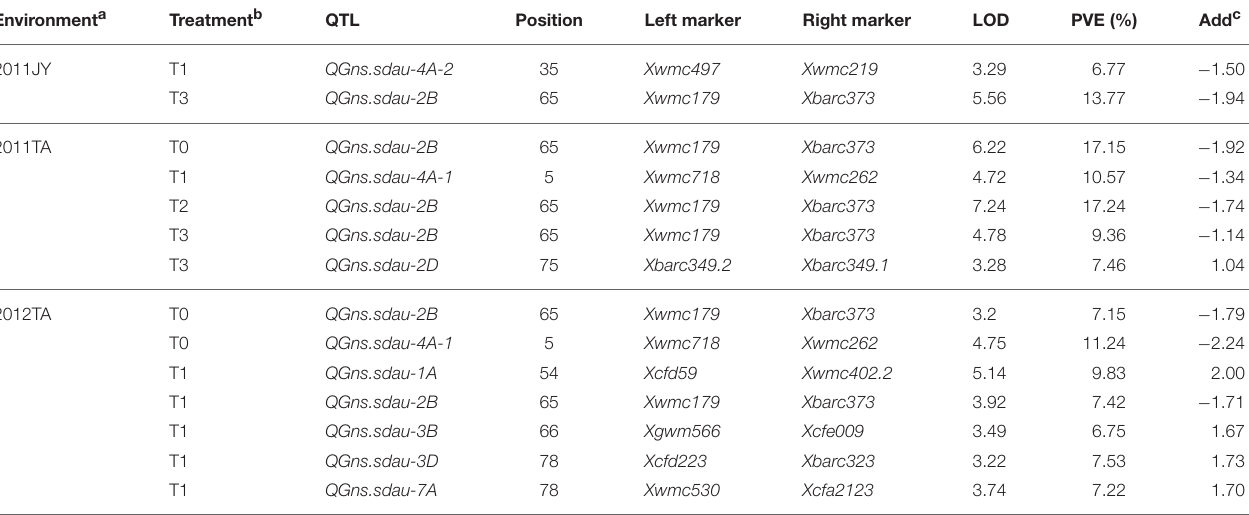
a and b are the same as those for Table 3 . c Epistatic